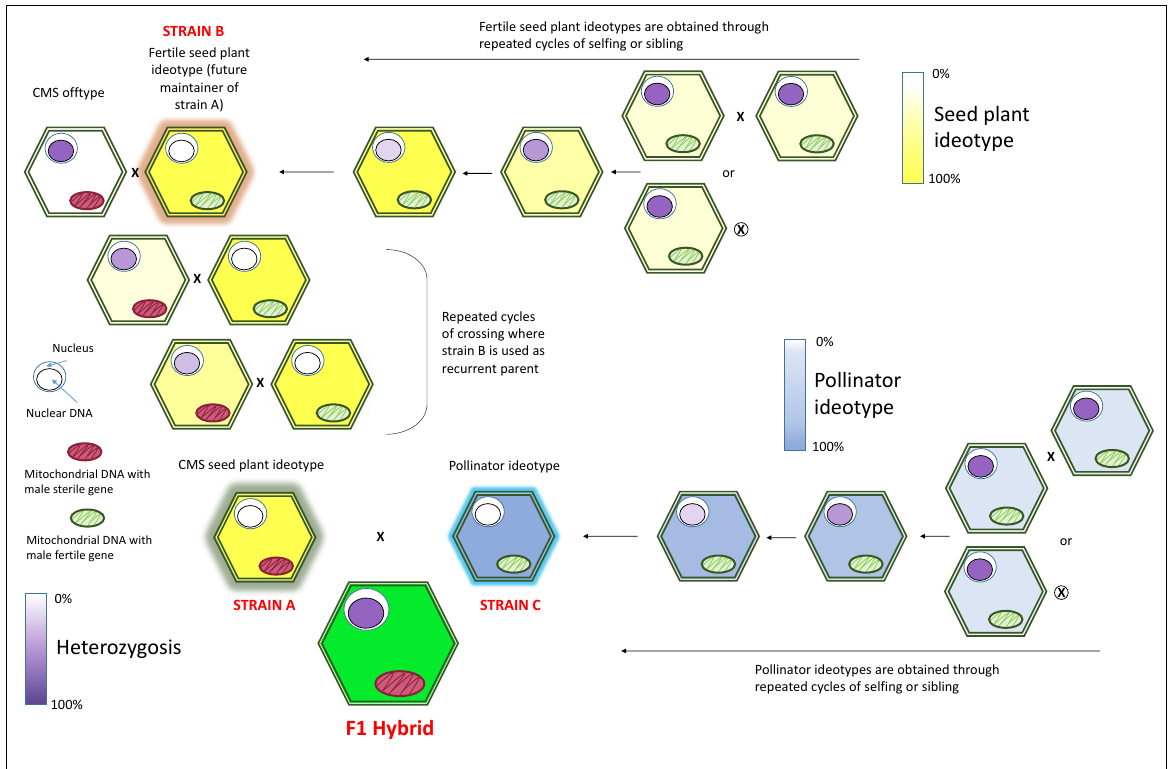
Figure 1. Simplified breeding scheme describing the development of F1 hybrids based on the exploitation of a cytoplasmic male sterility (CMS) system in combination with a maintainer line and an unrelated pollen donor or pollinator line. Three lines are used: a CMS seed line (strain A), a male fertile sister line (also known as maintainer line, strain B) and a pollinator line (strain C) with a general combining ability (GCA) with the CMS line. Strain B and C are initially obtained by means of several generations of selfing ( ⊗ ) or sibling ( × ) to achieve the desired ideotype (i.e., high uniformity and high homozygosis). The CMS seed line (strain A) is developed through backcross, using the newly constituted strain B (that acts as a recurrent parent) and a CMS genotype (used as a non-recurrent parent to transfer the male sterility trait into strain B). After several cycles of backcrossing (usually 6–7), the resulting progeny (strain A) will be isogenic to the B line except for the cytoplasm, which will be CMS. Strain B will finally serve as the maintainer of the newly obtained CMS seed